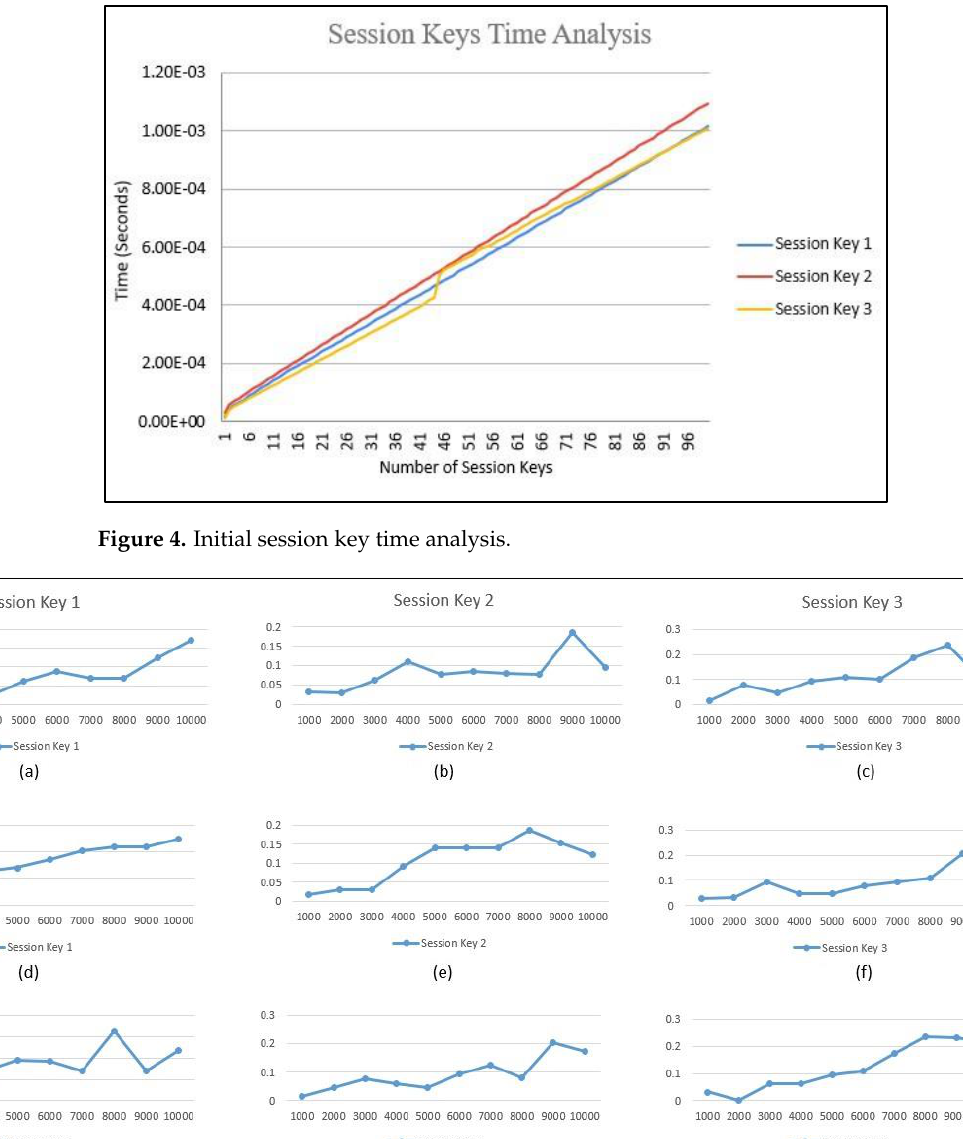
Figure 6. Total time analysis for the LCG: ( a ) GCC, ( b ) Borland, and ( c ) Turbo. In Figure 7, the protocol time analysis for mobile workstation, IoT device 1, and IoT device 2 is shown. The time required on the mobile workstation is less when compared to IoT devices due to the high processing capacity, as shown in Table 2. While increasing the nodes from 100 to 1000, the total time can be seen increasing due to computation require- ments for the protocol implementation. In comparison, the protocol implementation on the Raspberry Pi IoT device can be seen increasing smoothly due to less computation ca- pacity. Therefore, the total time is smoother in the low-end device but has higher time implementation requirements on the resource-constrained devices.